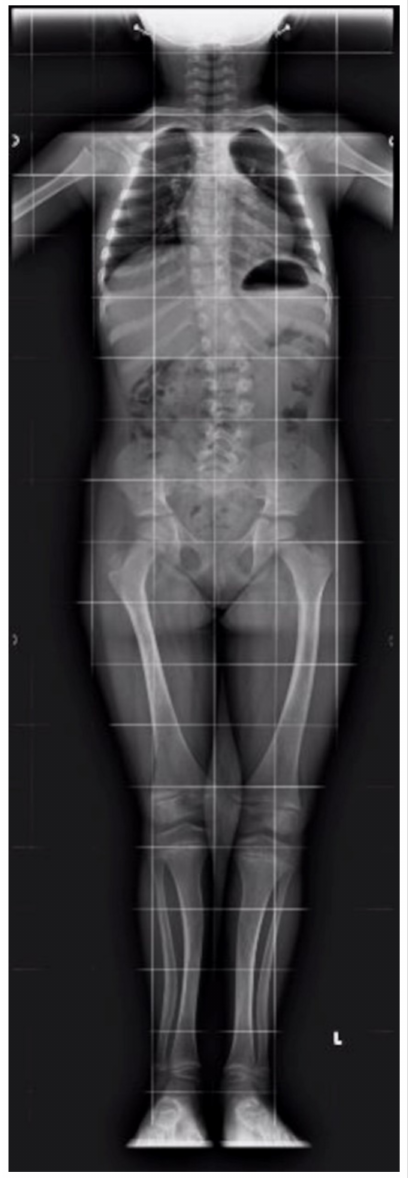
Figure 2. X-ray at the end of